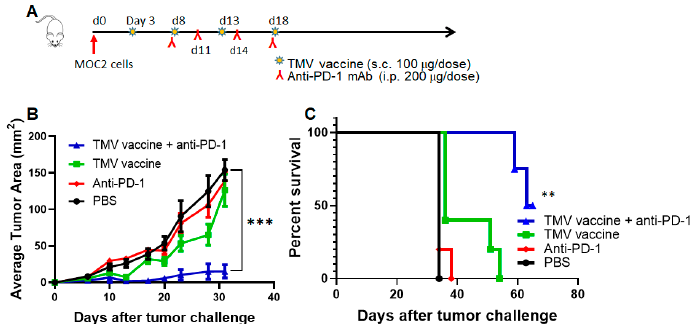
Figure 5. TMV vaccine + anti-PD-1 antibody inhibits MOC2 tumor growth. ( A ) C57BL / 6 mice ( n = 5) were inoculated with 5 × 10 5 MOC2 cells s.c. on the flank. TMV vaccine was administered starting on day 3 and every five days for four doses (100 µ g / dose). For the mice receiving mouse anti-mouse-PD-1 mAb, treatment started on day 8 (200 µ g / dose, i.p. route) and continued every three days for four doses (inverted red Y). ( B ) Tumor size and ( C ) survival are shown. Values are Mean ± SEM and Student’s t -test between PBS and combination group. Log-rank (Mantel–Cox) test was used for determining the significance of the di ff erence in the survival of mice. ** p < 0.01, *** p < 0.001. One outlier in the combination group is not included in the analysis.